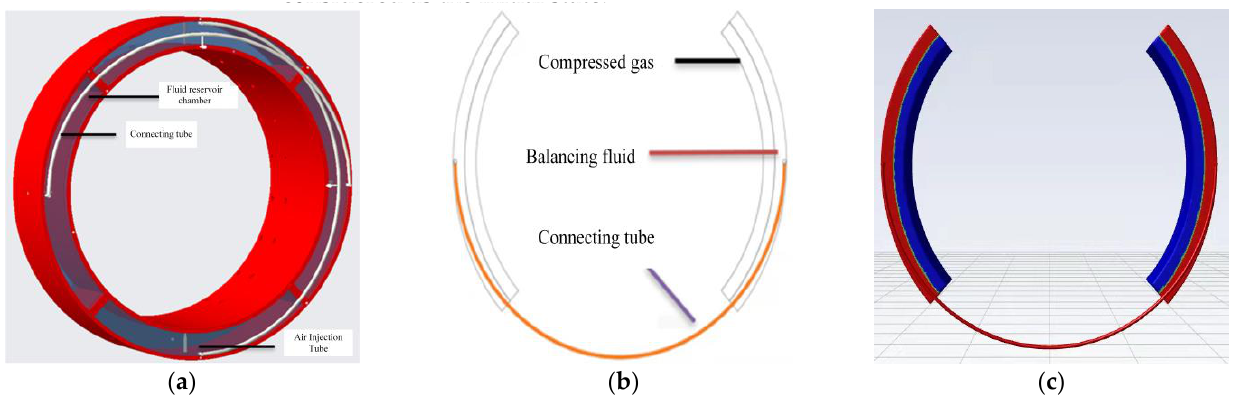
Figure 11. Grid division diagram. ( a ) Gas – liquid flow field inside the actuator. ( b ) Gas – liquid fluid domain modeling. ( c ) Gas – liquid two-phase nephogram diagram.